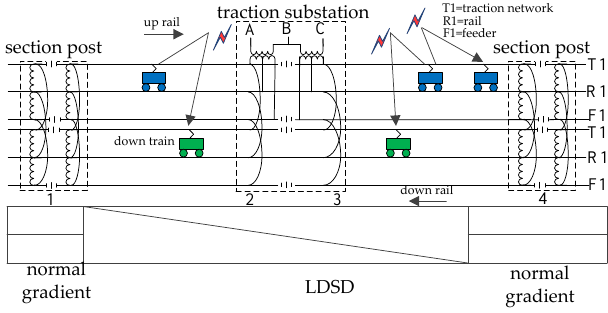
Figure 5. Regenerative energy flow in the traction power supply system.